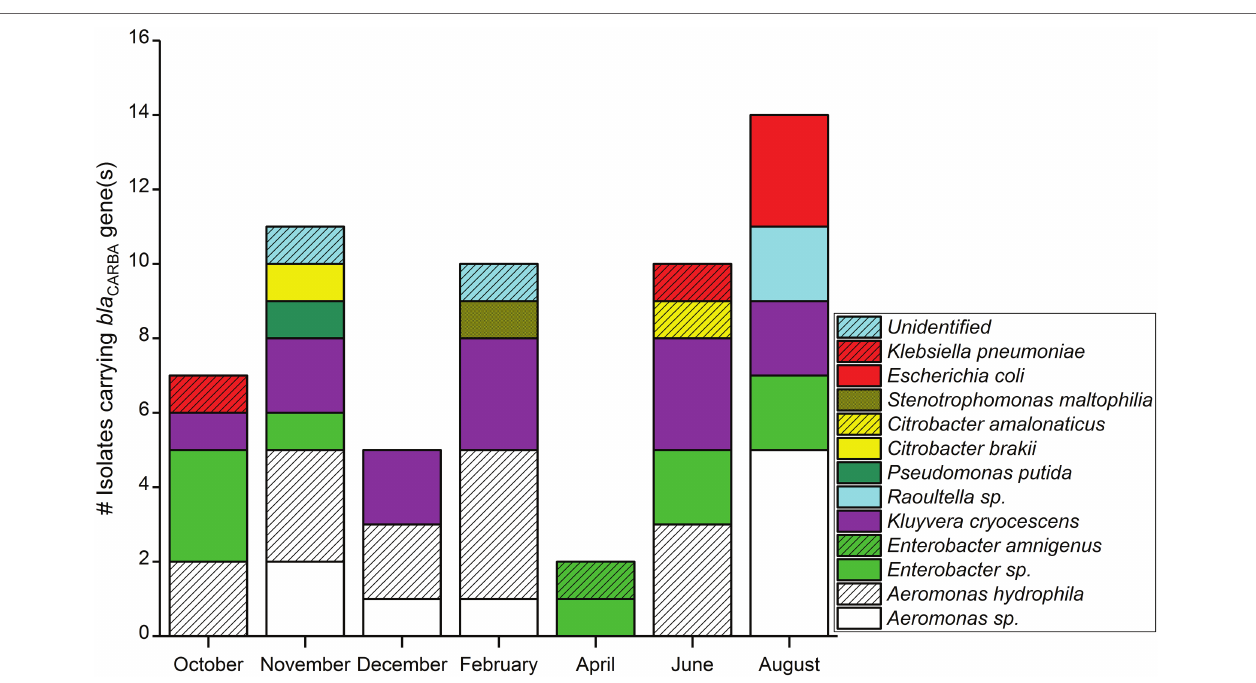
FIGURE 2 | bla CARBA gene-carrying Gram-negative bacterial isolates ( n = 59) isolated in wastewater influent in Helsinki, Finland